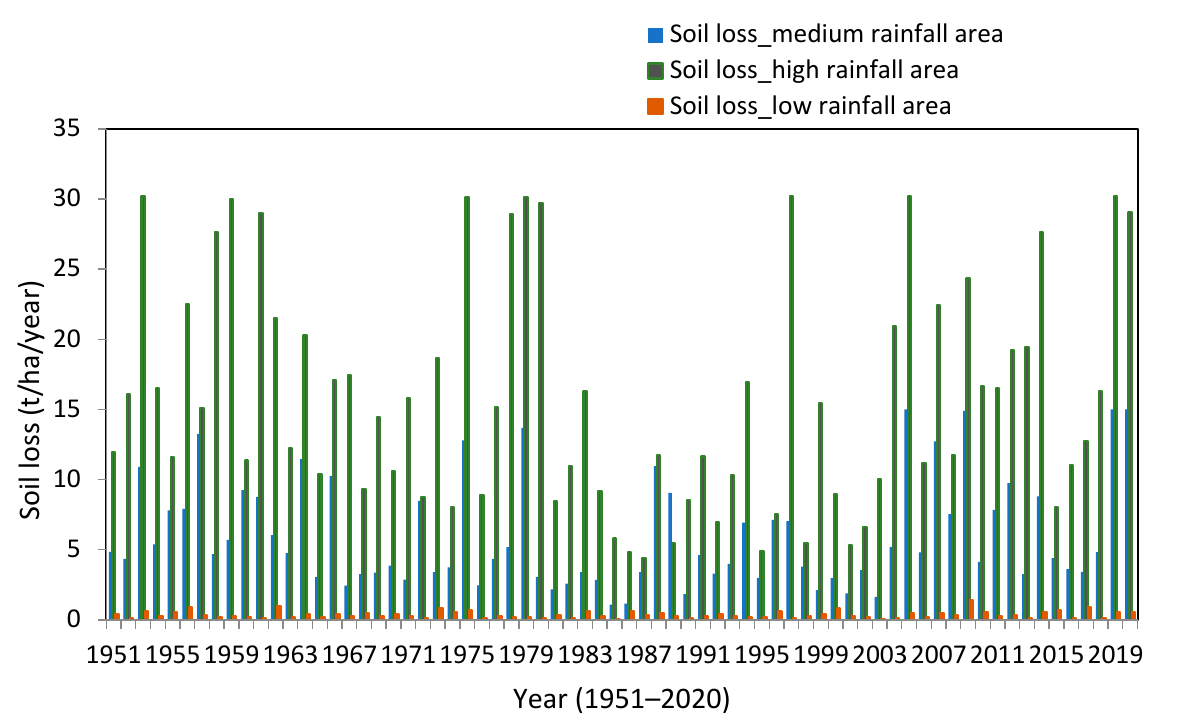
Figure 6. Temporal variation in soil loss at low, medium and high-rainfall areas of Belgavi district. The rainfall, erosivity, and soil loss were also analyzed separately for high-, medium-, and low-rainfall regions of Belgavi district during different rainfall years. Out of 70 years, low-rainfall regions experienced drought for 31% of the years with a rainfall of 260 to 419 mm, erosivity of 1047 to 2993 MJ mm ha − 1 h − 1 year − 1 , and soil loss of 0.1 to 0.3 t ha − 1 y − 1 , and 39% of the years were normal with a rainfall of 430 to 618 mm, erosivity of 2608 to 4734 MJ mm ha − 1 h − 1 year − 1 , and soil loss of 0.3 to 0.5 t ha − 1 y − 1 (Table 4). The remaining 30% of the years were above normal with rainfall varying from 619 to 1085 mm, erosivity varying from 3504 to 9396 MJ mm ha − 1 h − 1 year − 1 , and soil loss varying from 0.37 to 0.99 t ha − 1 y − 1 .